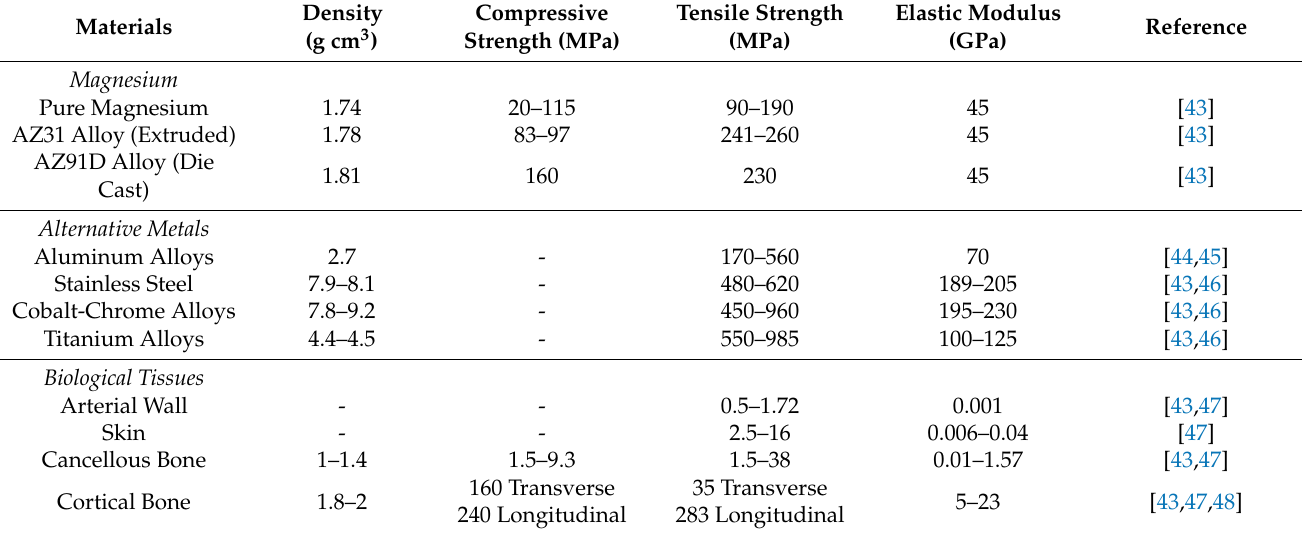
Table 1. Selected Mechanical